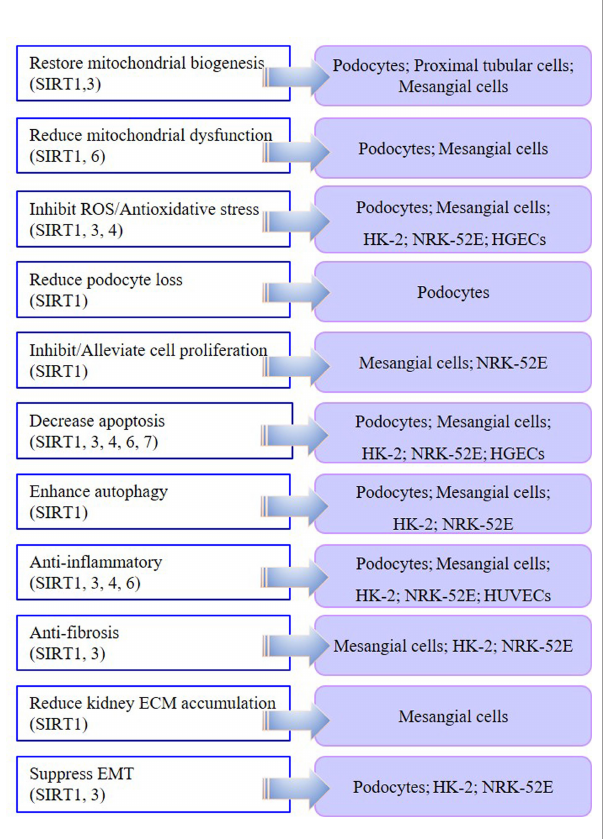
FIGURE 1 | Biological role of SIRT1 – SIRT7 in different DKD cell